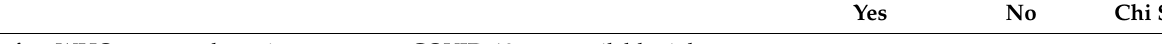
Table 4. Dentists’ vaccine acceptance and attitudes towards